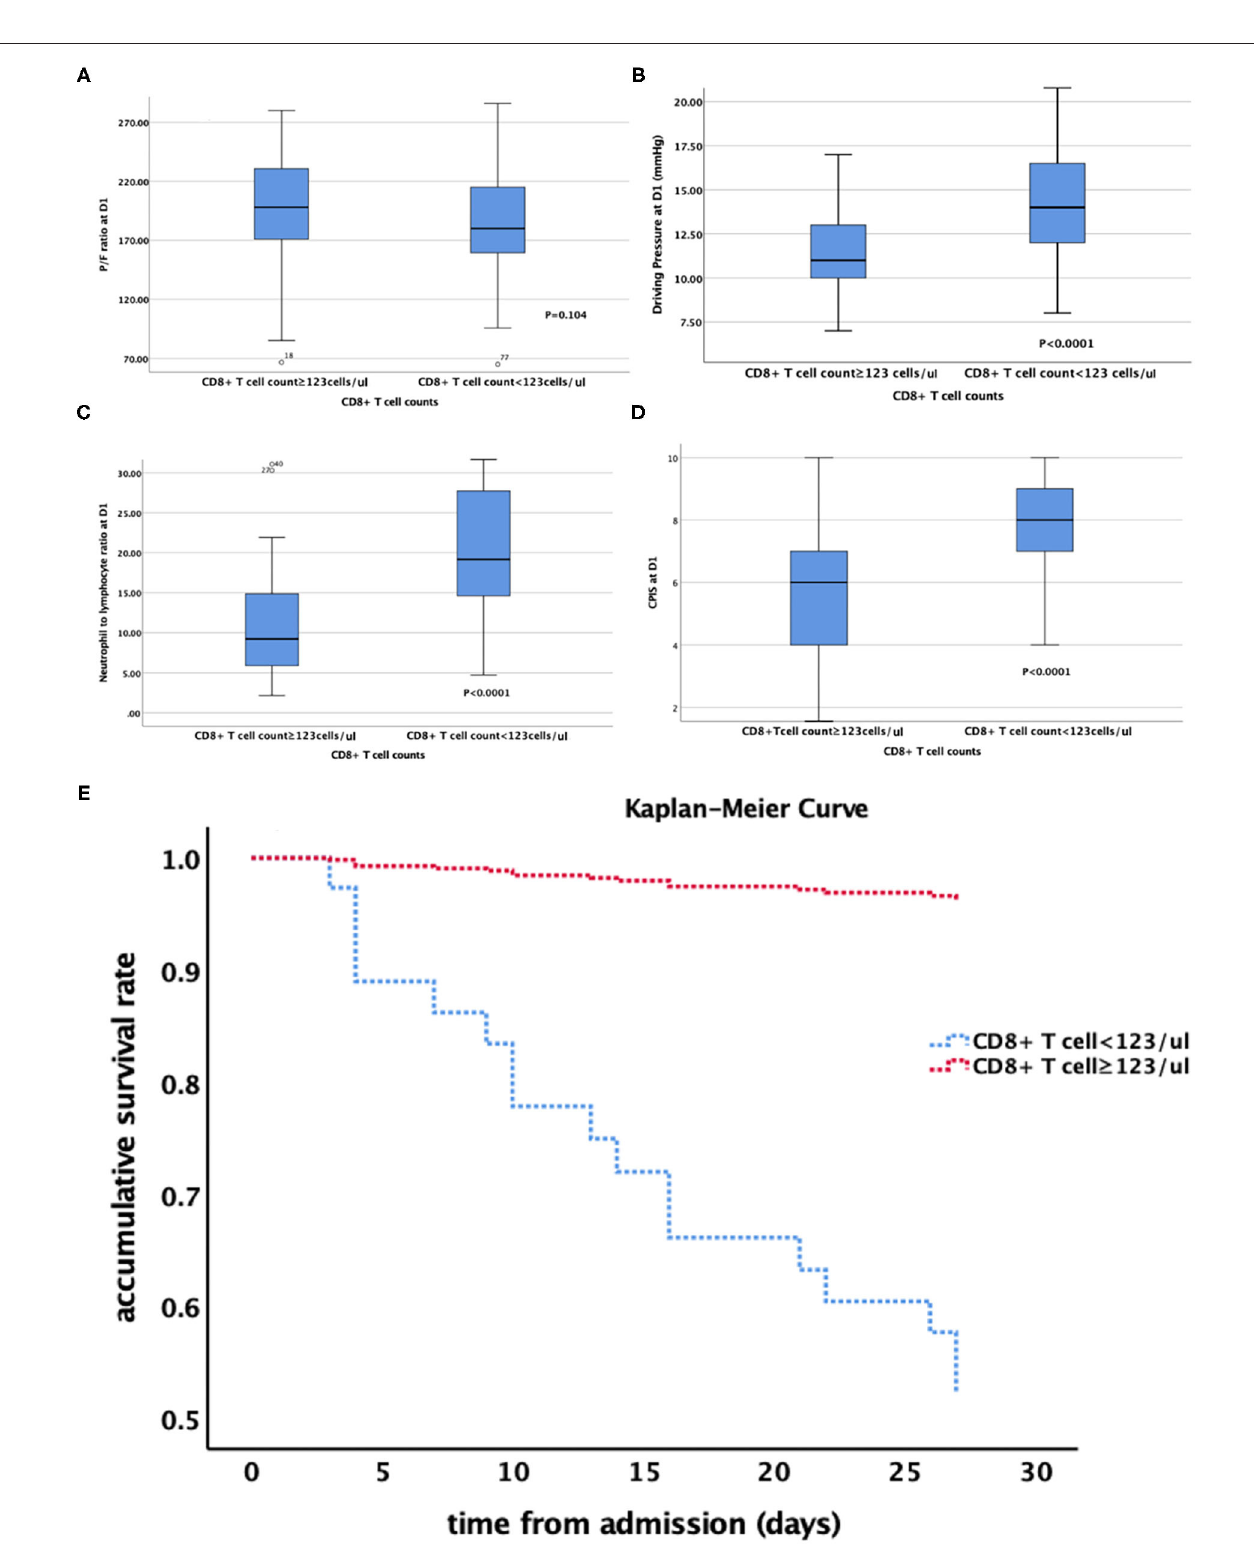
FIGURE 3 | (A–E) relationship between CD8 + T cell count and (A) P/F ratio; (B) Driving Pressure; (C) Neutrophil to lymphocyte ratio; (D) CPIS. (E) the Kaplan-Meier curve of patients with different CD8 + T cell counts. P/F ratio at D1 PaO 2 :FiO 2 at admission; CPIS, clinical pulmonary infection score.